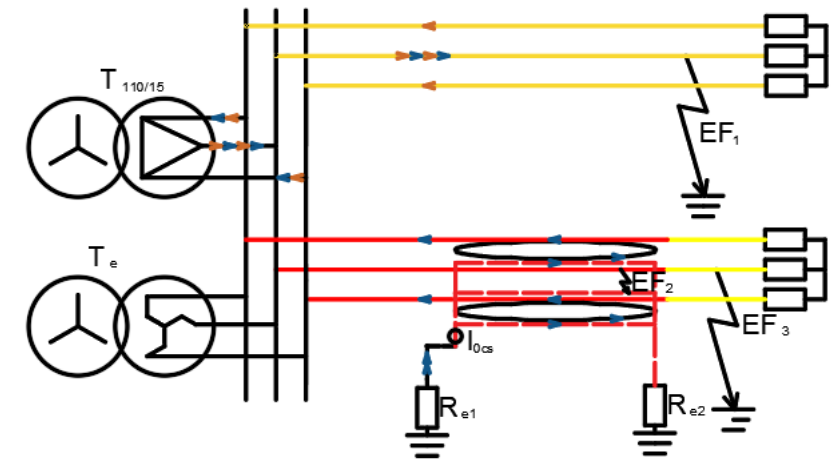
Figure 7. Capacitive component of earth fault current flow in mixed feeder; cable line marked with red; overhead line marked with yellow; another power lines marked with green; Te —grounding transformer; Ts —secondary winding of 110/15.